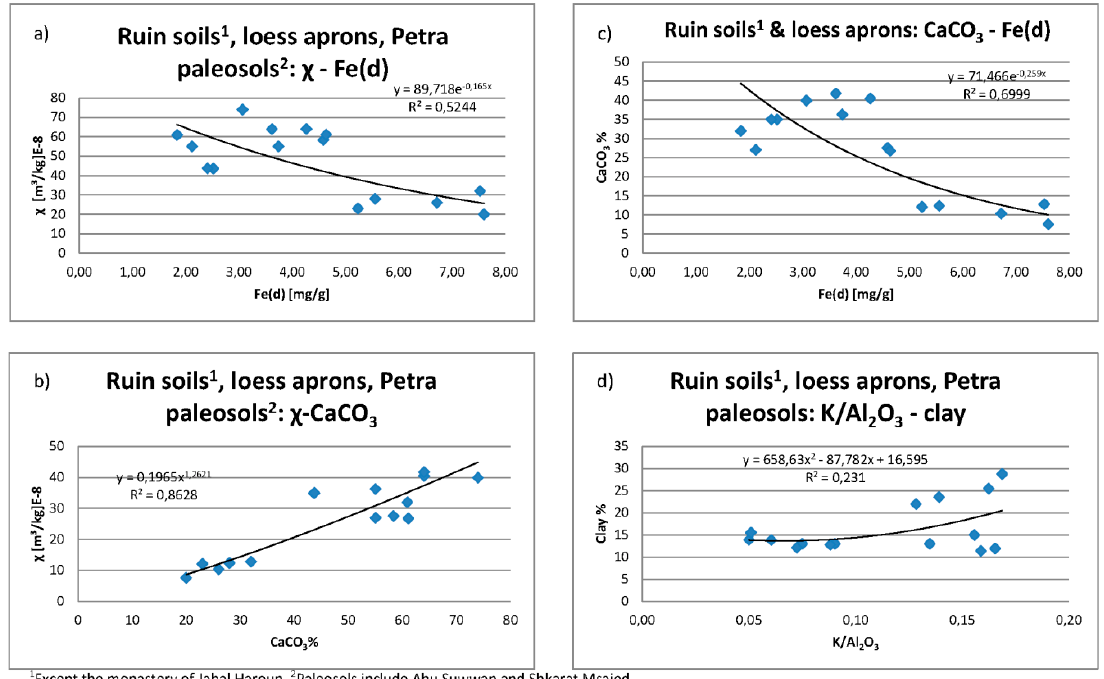
Figure 11. ( a ) Correlation of magnetic susceptibility χ and dithionite-extractable iron Fe(d) for the ruin soils, loessial aprons, and paleosols; ( b ) connection of magnetic susceptibility χ with calcium